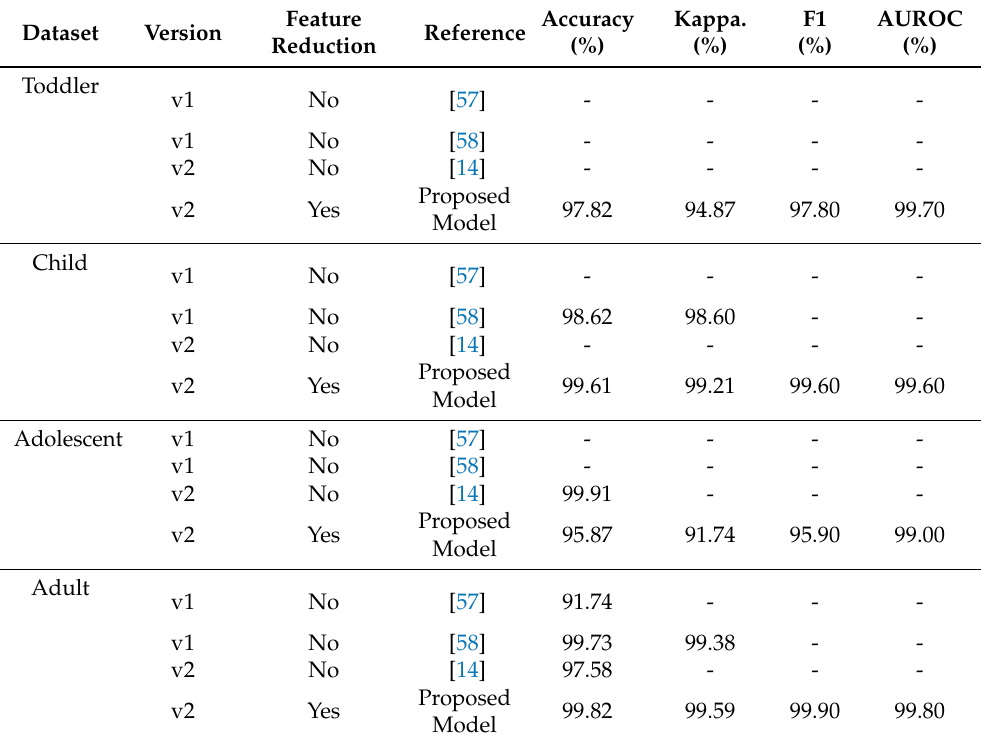
Table 25. Comparison of proposed model with other previous